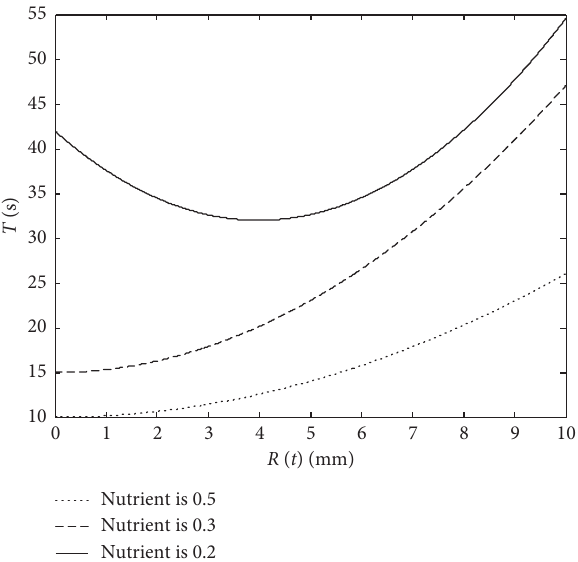
Figure 2: The trend of multiplication time T with R ( t ) under different nutrient concentrations.